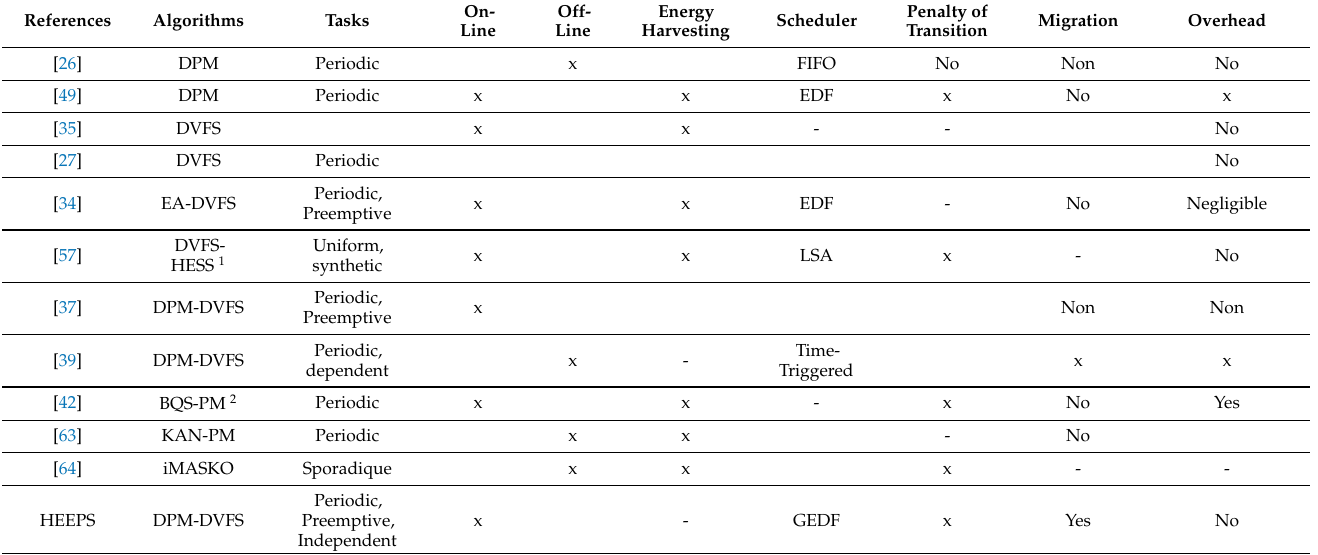
Table 6. Comparison of HEEPS with Existing